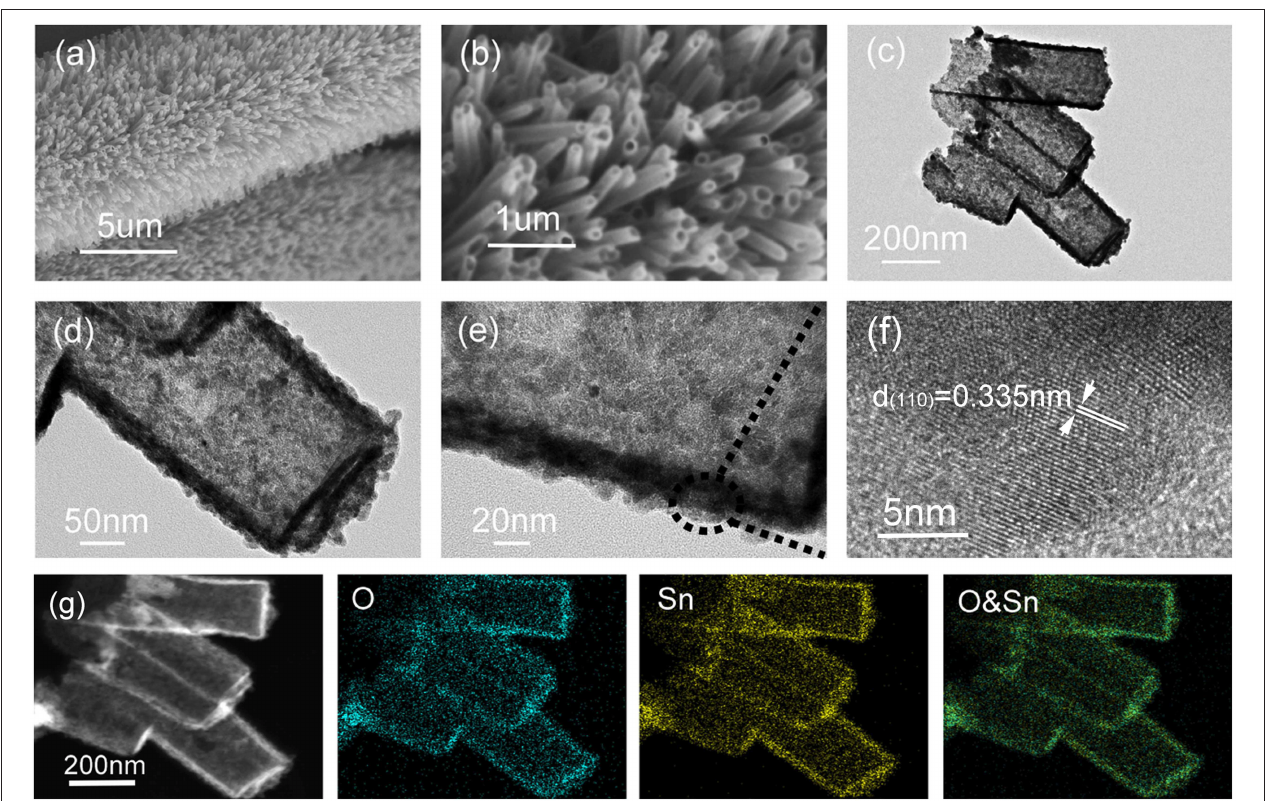
FIGURE 4 | SEM and TEM images of CC/SnO 2 nanotube arrays. (a,b) SEM images of CC/SnO 2 nanotube arrays at different magnifications. (c) TEM images of SnO 2 nanotubes. (d–f) HRTEM images of SnO 2 nanotubes. (g) TEM elemental mapping images of SnO 2